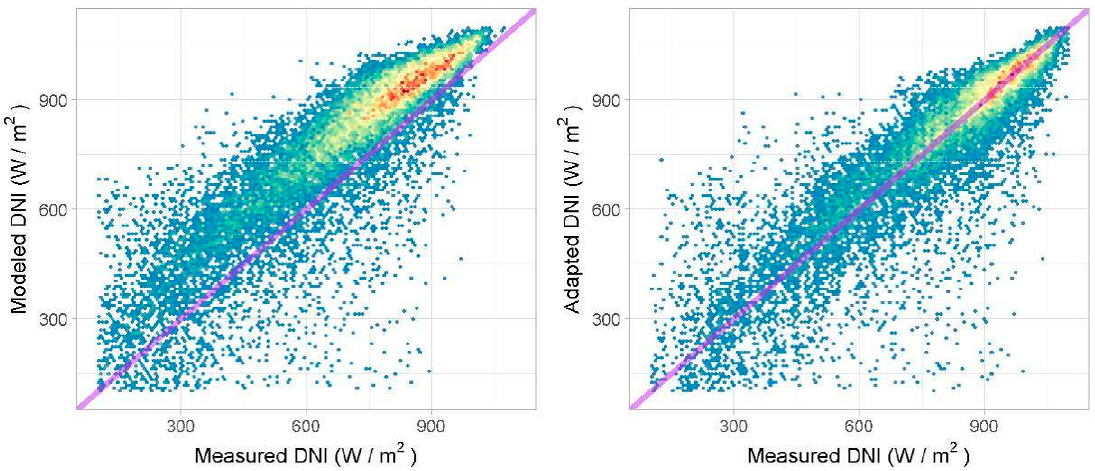
Figure 3. DNI scatterplots between daytime modeled (left) and adapted (right) DNI with respect to the measured ones at GOB site (2013–2017) using the year 2013 for the site-adaptation.